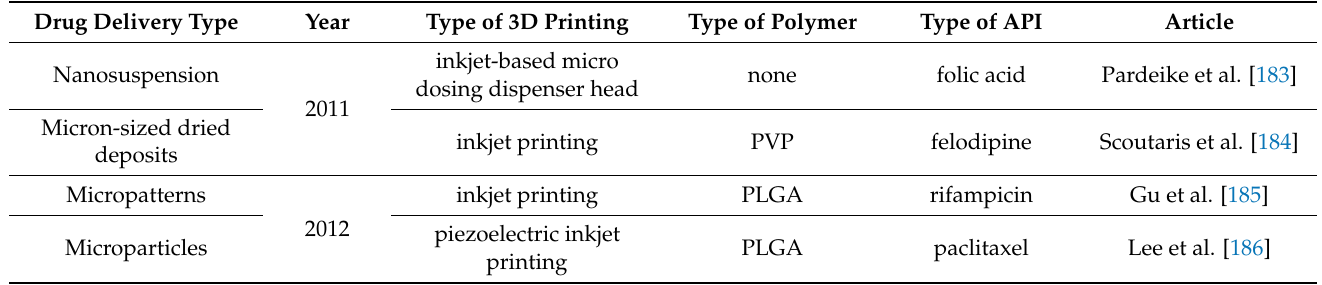
Table 9. The grouping of the manufactured micro- and nanoscale drug delivery systems based on the publication year and then in alphabetical